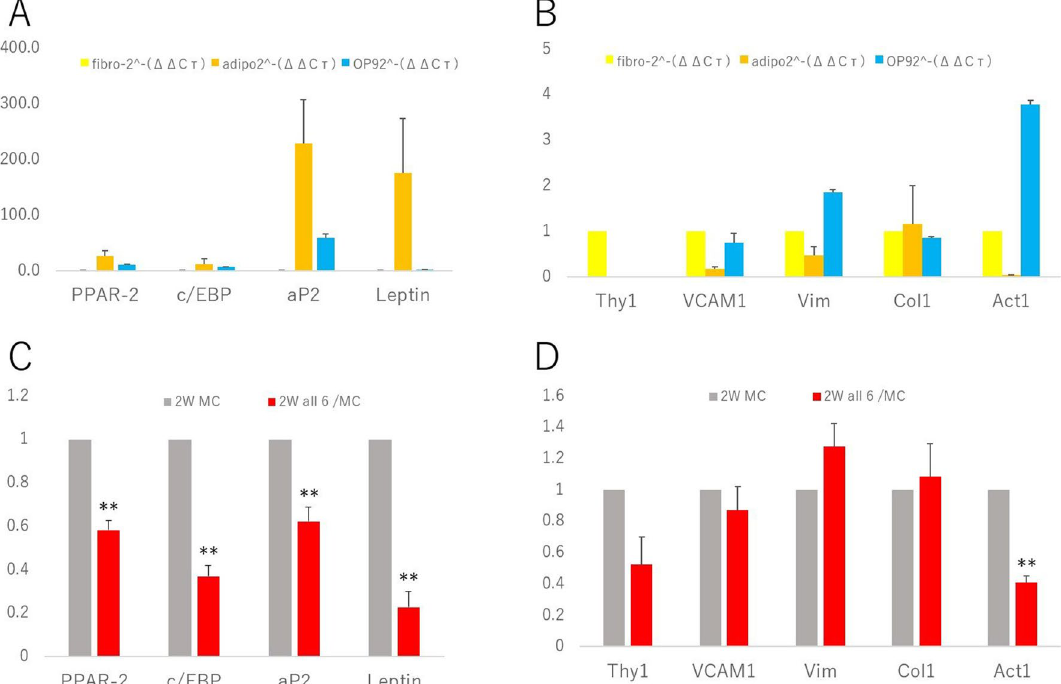
Figure 3. Quantitative data of gene expression. ( A – D ) Four candidate genes as markers of adipocytes. All of them were expressed at higher levels in adipocytes than in OP9 cells and fibroblasts ( A ). Five candidate genes as markers of fibroblasts. Thy1 expression was higher in fibroblasts than in OP9 cells and adipocytes. Col1 was expressed in any of the cells, with no distinct difference. VCAM1, Vim, and Act1 were expressed at higher levels in fibroblasts and OP9 cells than in adipocytes ( B ). The expression of four candidate genes as markers of adipocytes in negative control (MC: Medium Change) cells and transfected (all of the 6 master regulators) cells after 2 weeks of culture ( C ). The expression of five candidate genes as markers of fibroblasts in MC cells and transfected cells after a 2-week culture ( D ). (n = 8). Values shown are the means + SEM. P-values were determined by a Student’s t-test. **P <